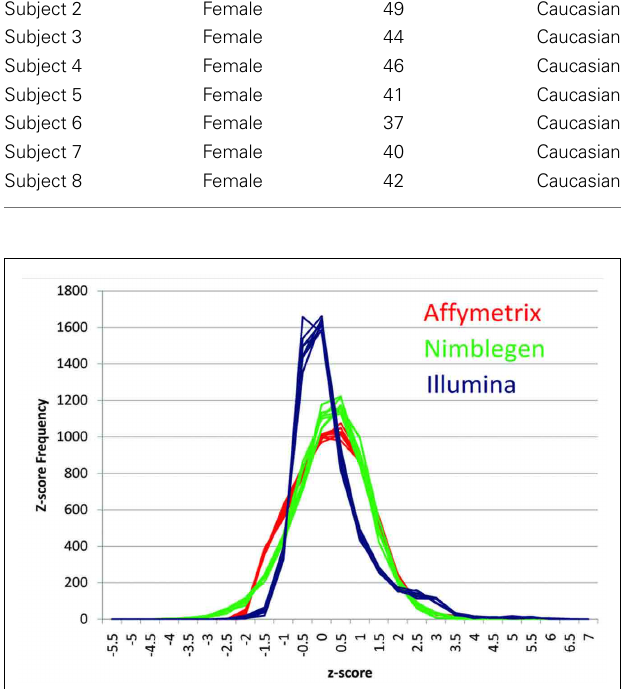
FIGURE 1 |The distribution of z -transformed methylation of gene expression values ( Y -axis) from each platform for each of the subjects in the study. NimbleGen values are in green, Affymetrix values are in red, and Illumina values are in blue.